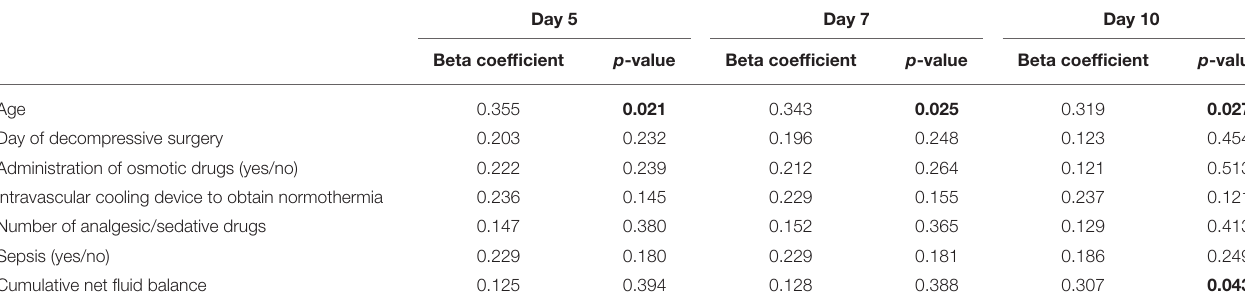
TABLE 4 | Impact of treatment measures on functional